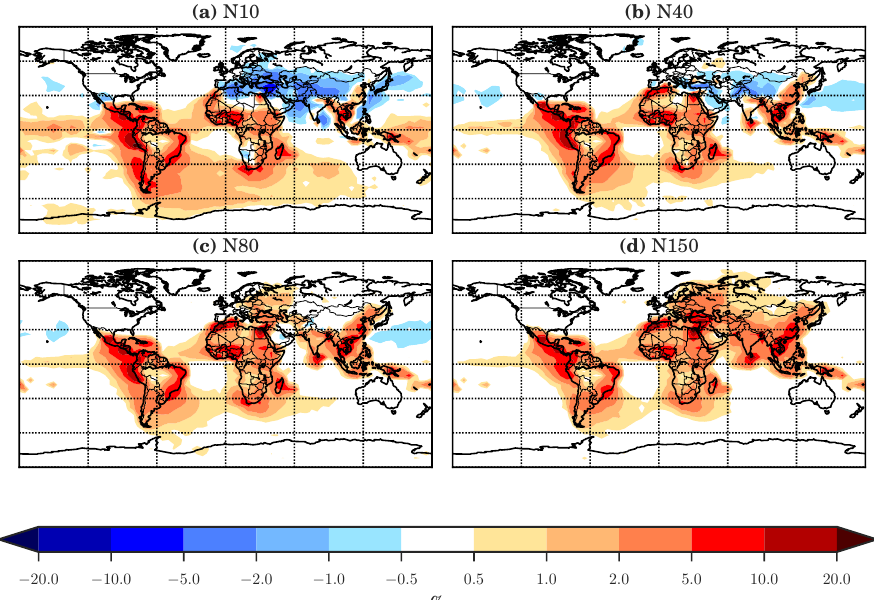
Figure 4. Annual-mean percent change in boundary-layer (a) N10, (b) N40, (c) N80, and (d) N150 for domestic-waste combustion (BASE- WASTE_OFF).